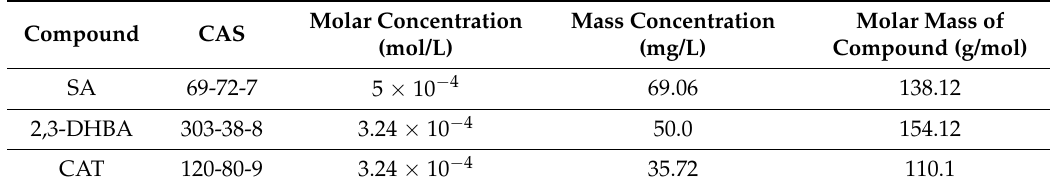
Table 1. Concentrations of solutions of chemical compounds used in the